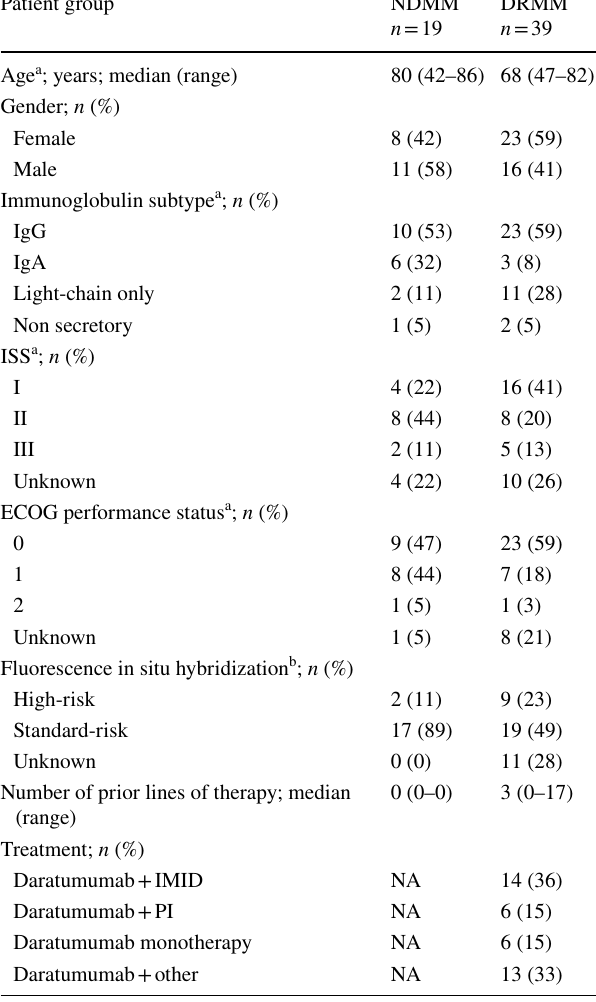
Table 1 Patient